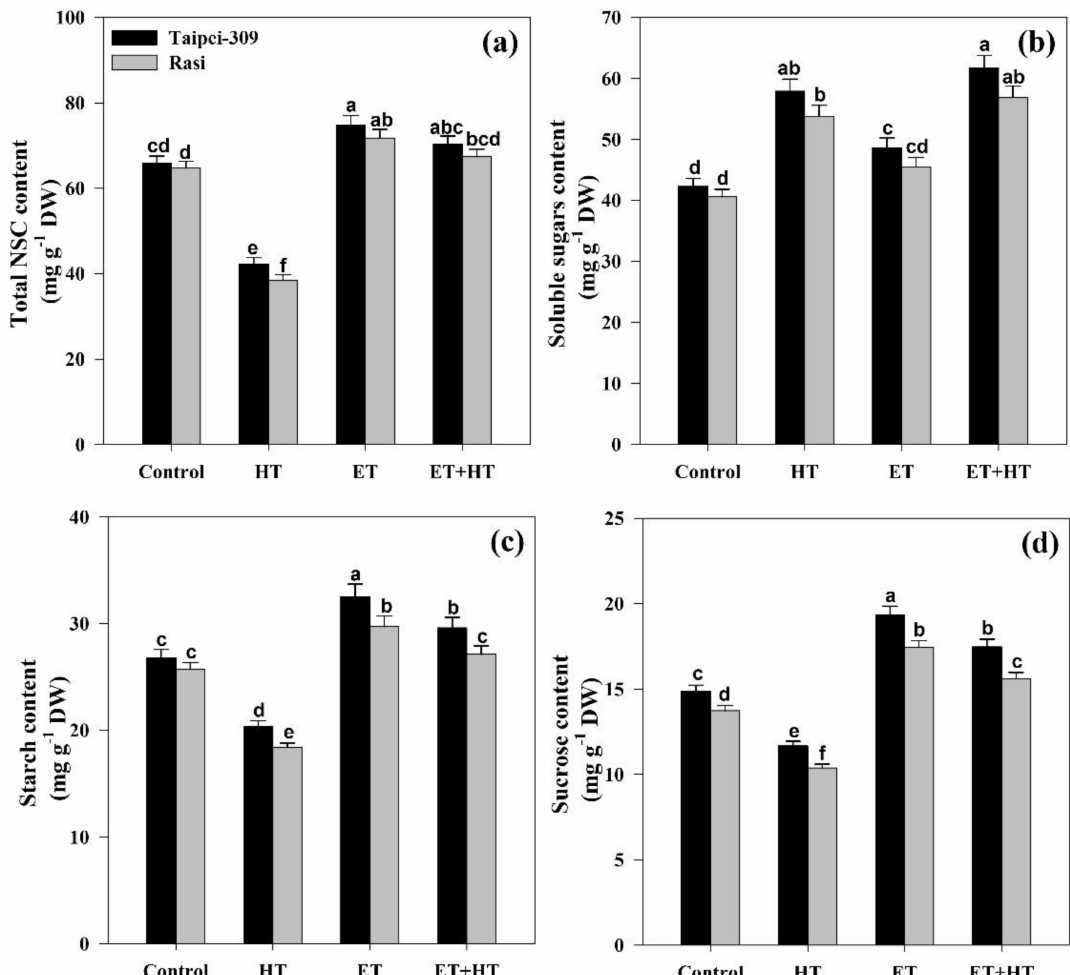
Figure 4. ( a ) Total non-structural carbohydrate (NSC) content, ( b ) soluble sugar content, ( c ) starch content, and ( d ) sucrose content in Taipei-309 and Rasi cultivars of rice ( Oryza sativa L.) at 30 DAS. Plants were grown with/without high-temperature (HT) stress and treated with a foliar spray of 1.6 mM ethephon (ET) at 15 DAS. Data are presented as treatment means ± SE ( n = 4). Bars with the same letters did not differ significantly by the LSD test at p < 0.05. DAS, days after sowing; DW, dry